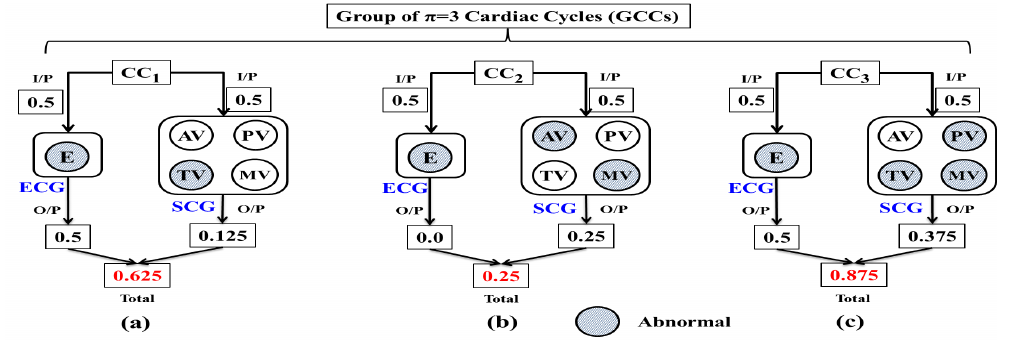
Figure 11. Combined analysis of ECG and multi channel SCG ( a ) Cardiac cycle 1; ( b ) Cardiac cycle 2; ( c ) Cardiac cycle